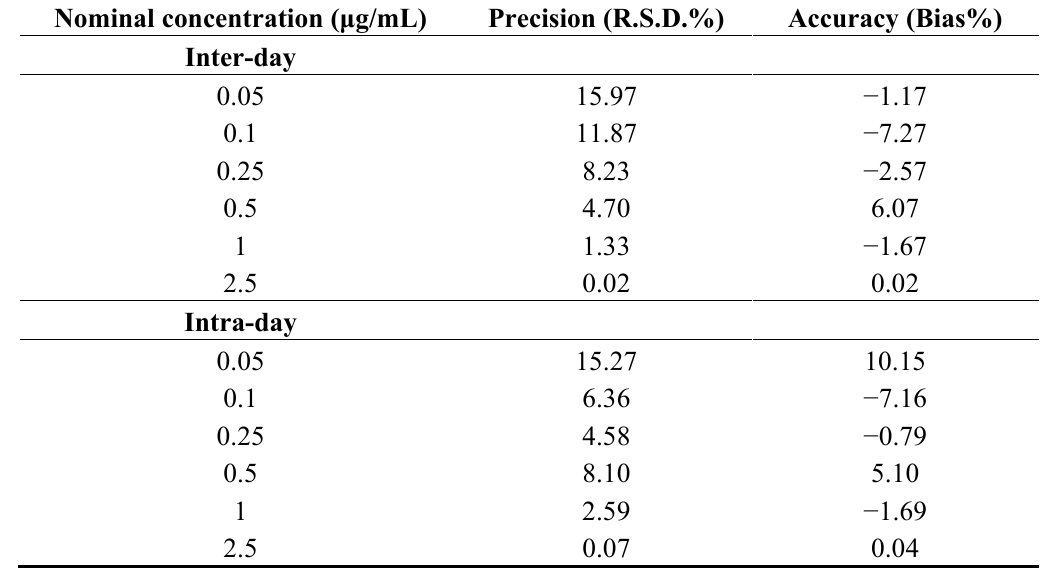
Table 1. Method validation for the intra-assay and inter-assay precision (R.S.D. %) and accuracy (Bias %) of the UPLC-MS/MS method for the determination of DBP in rat plasma.